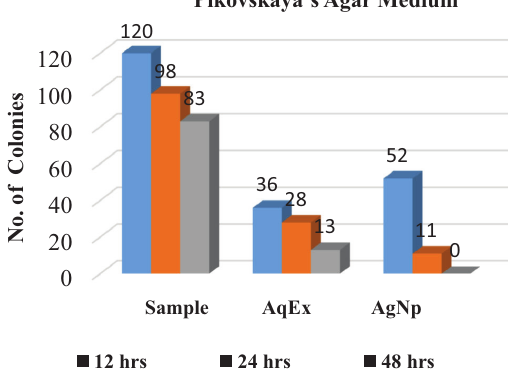
Figure 7. Total bacterial count (PSB) in PSB Pikovskaya’s Agar Medium – values are expressed as Mean ( n = 3)